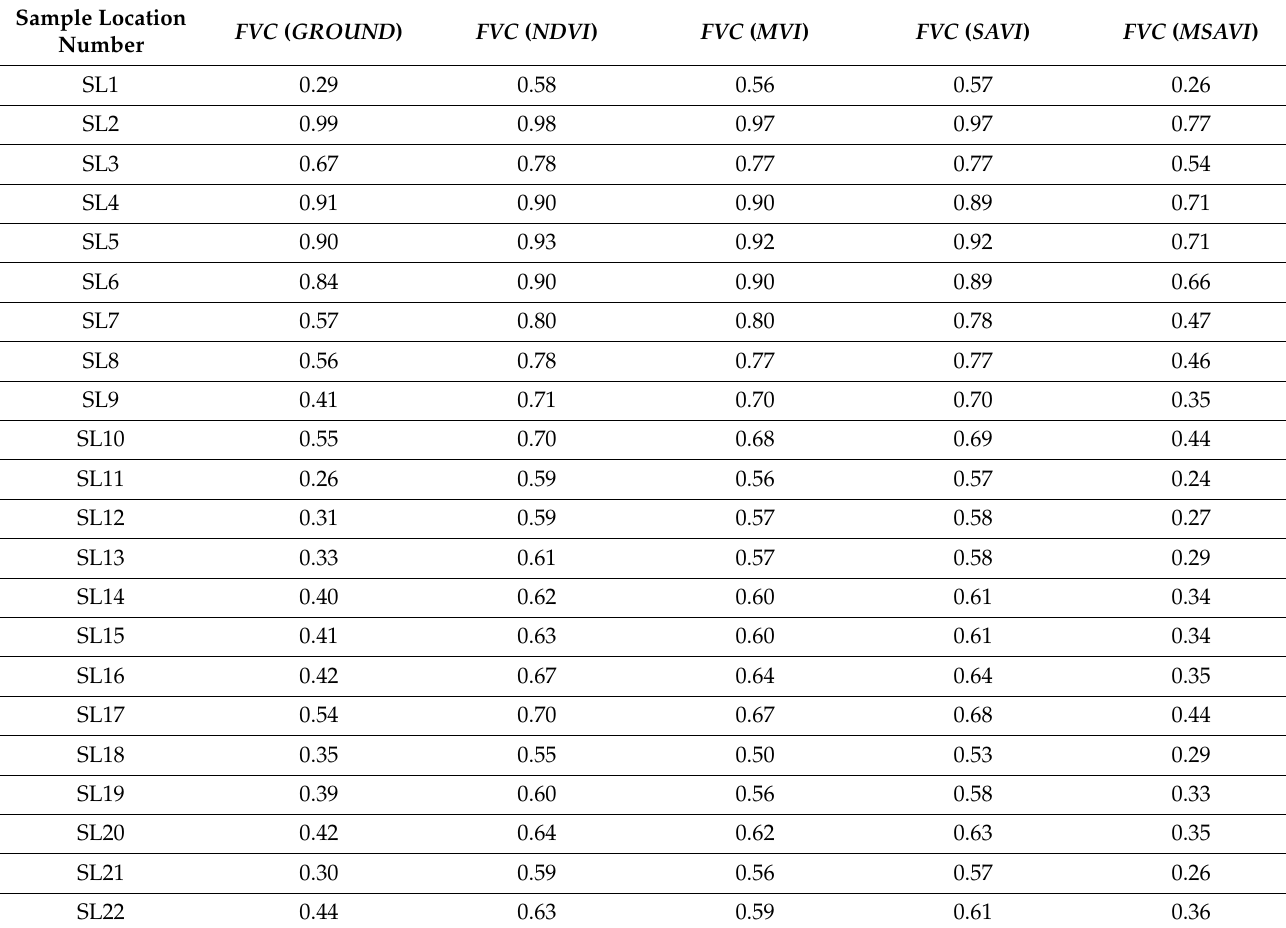
Table 3. Ground forest FVC and image forest FVC calculated from different vegetation